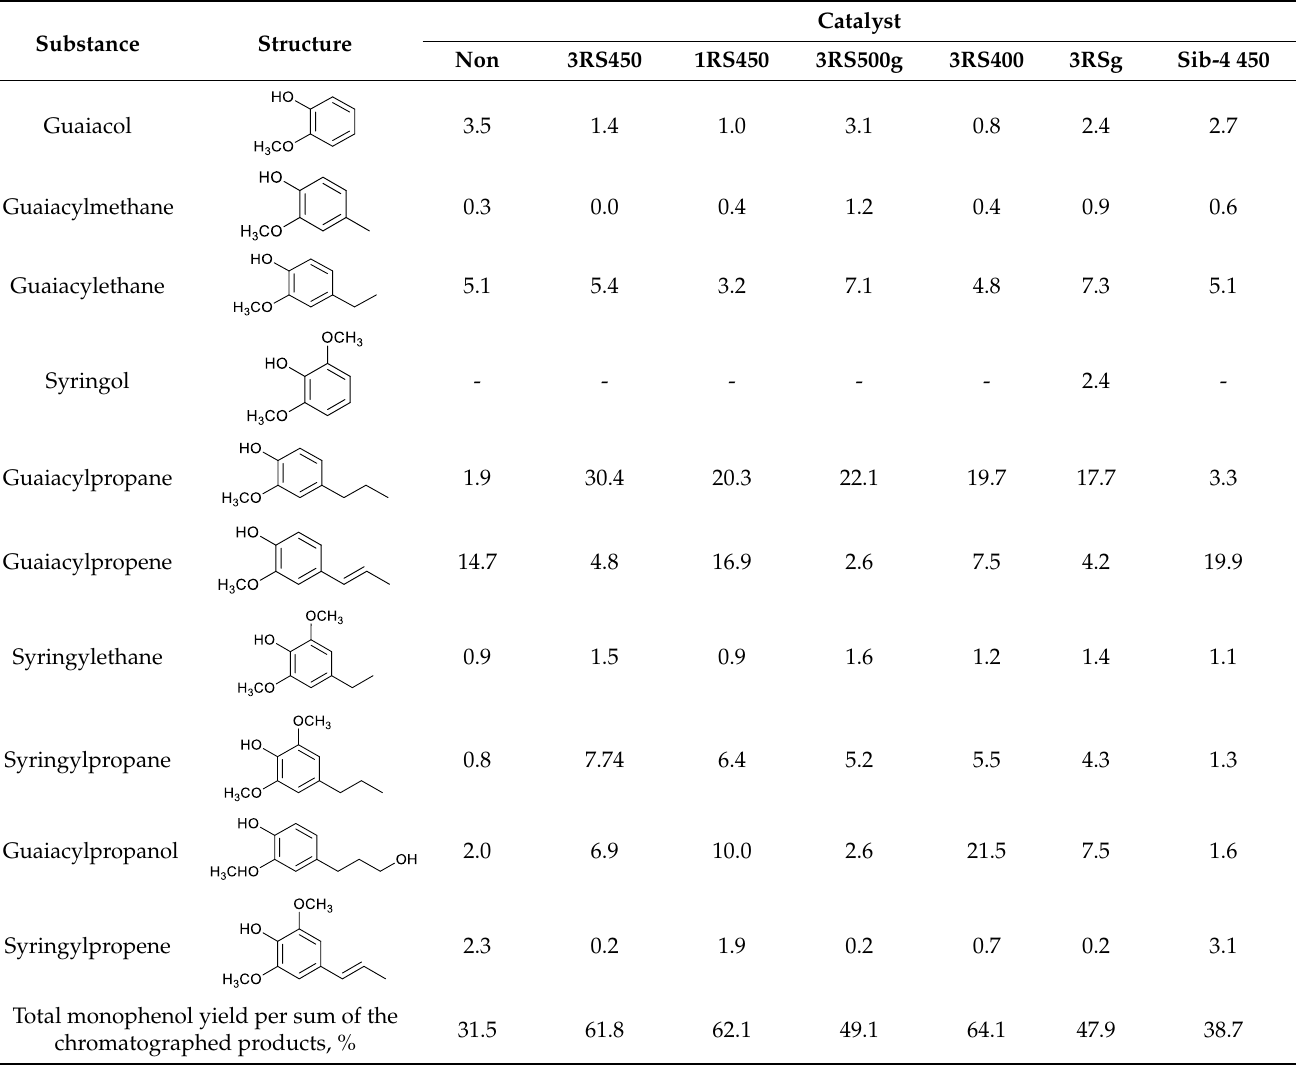
Table 7. Yield (relative to the areas of all peaks, %) and composition of monomeric methoxyphenols included in the liquid products of noncatalytic and catalytic hydrogenation of flax shive in subcritical ethanol at 225 °С.